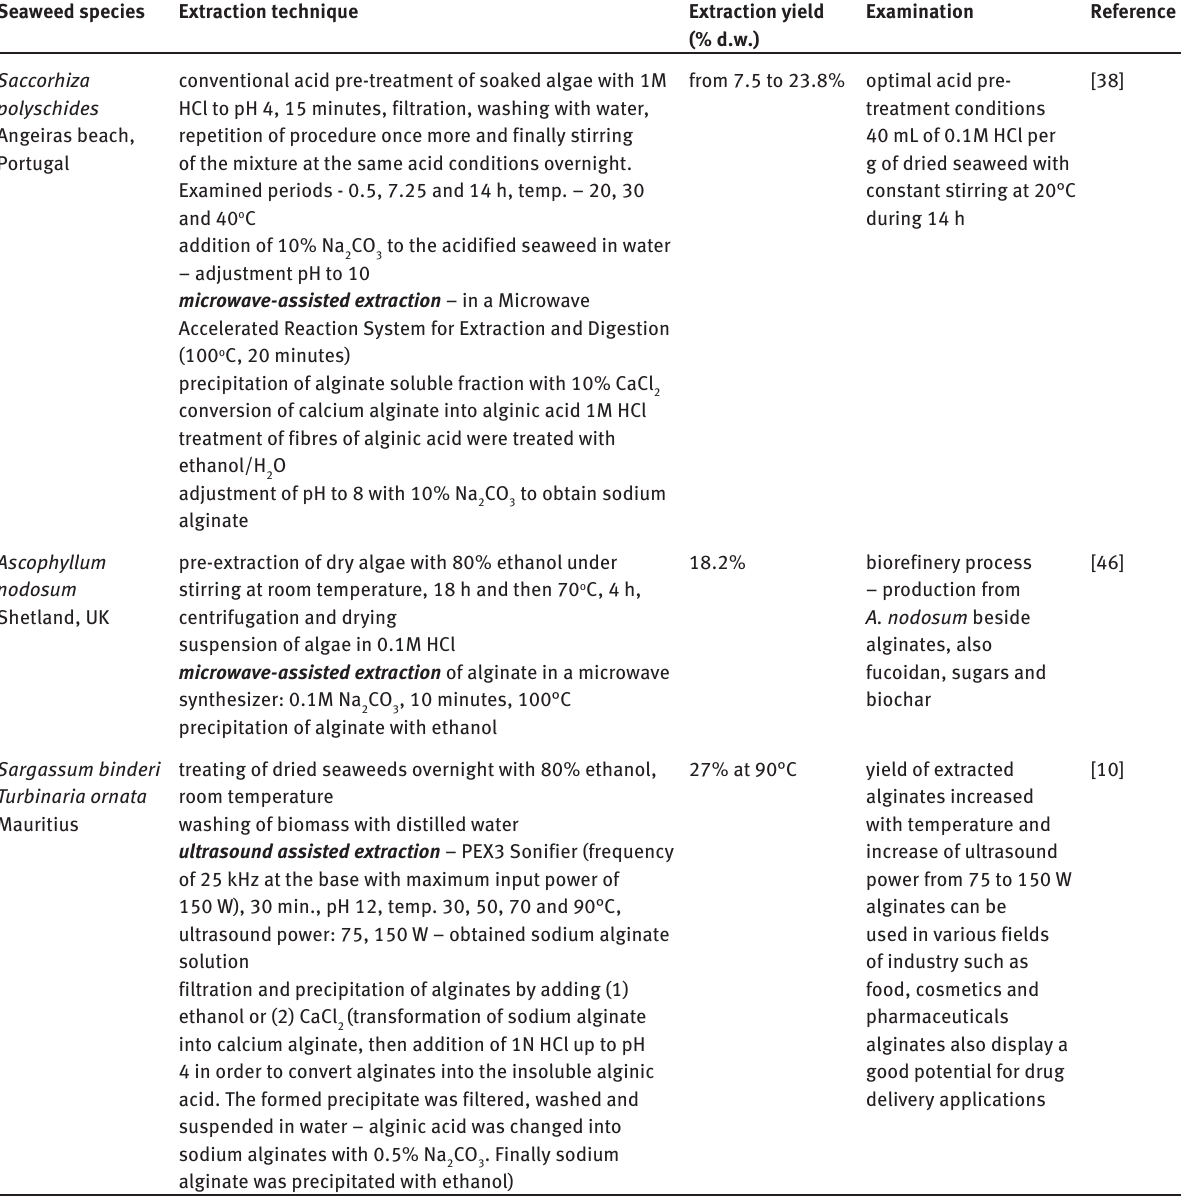
Table 2: Novel extraction techniques of alginates. Seaweed species Extraction technique Extraction